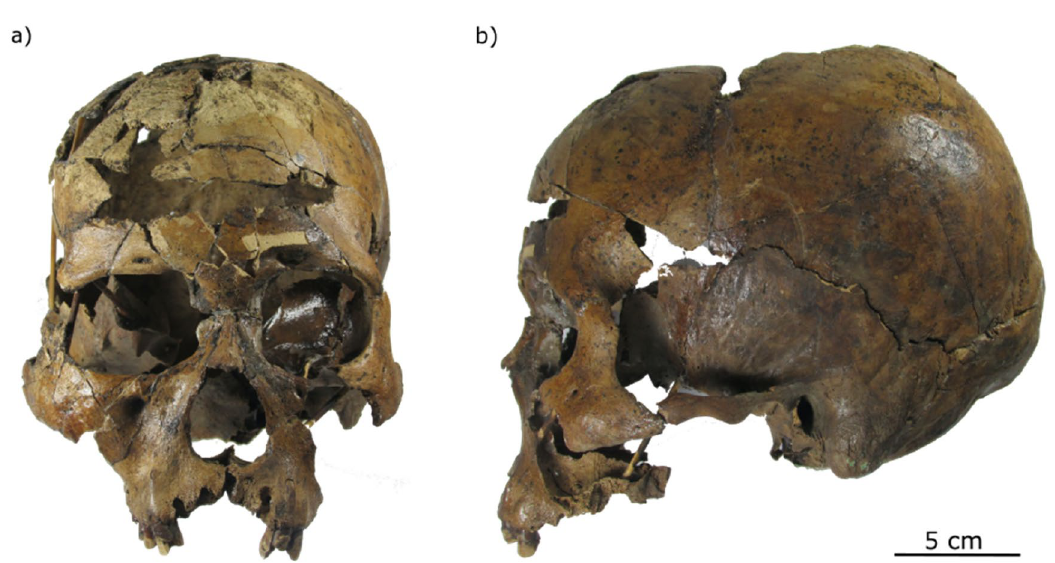
Figure 5. The Toca dos Coqueiros skull: ( a ) frontal view; ( b ) lateral view. This Figure has been adapted from images that belong to the FUMDHAM